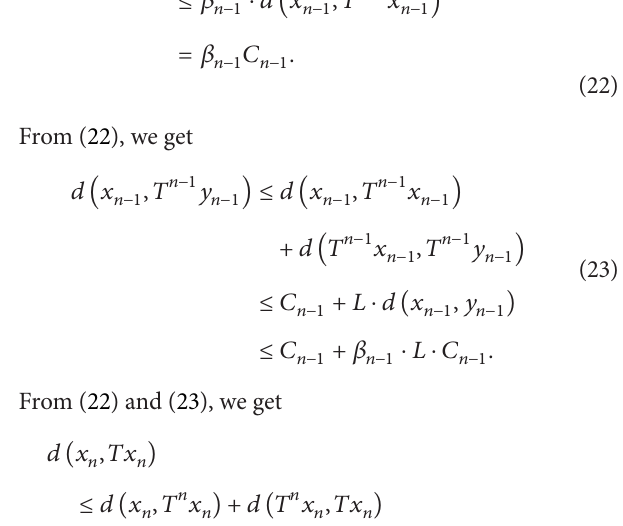
Algorithm 3. The sequences {𝑥 𝑛 } and {𝑦 𝑛 } defined by the iterative process